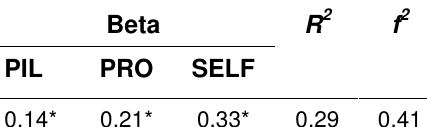
Standard Multiple Regression